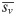
Plots for three scenarios, 1–3, representing three schools selected from the recreational fish-finder (RFF) outputs with different pixel skewness values: a) 2D scatter plots showing the influence of different combinations of mean volume backscattering strength (Sv) starting values and colour step values on the difference in Sv values (Sv diff) between the RFF and the scientific echosounder (SES) outputs (colour scale bar—low values indicate optimal estimates), cross-hatch denotes optimal colour step values at starting values of -65 dB; b) least-squares regressions between volume backscattering coefficients (sv¯) of the SES (transformed) and RFF outputs of the 36 matched schools using starting and colour step values for the RFF outputs as determined by the 2D scatter plot analyses, coefficients are given at the top of each plot and shaded areas denote the 95% confidence intervals; c) histograms showing the frequency of schools in 4 dB Sv bins for the SES-derived schools, the RFF-derived schools before application of a correction factor as predicted by the linear regression models (b), and the RFF-derived schools with this correction factor applied (RFF corr).